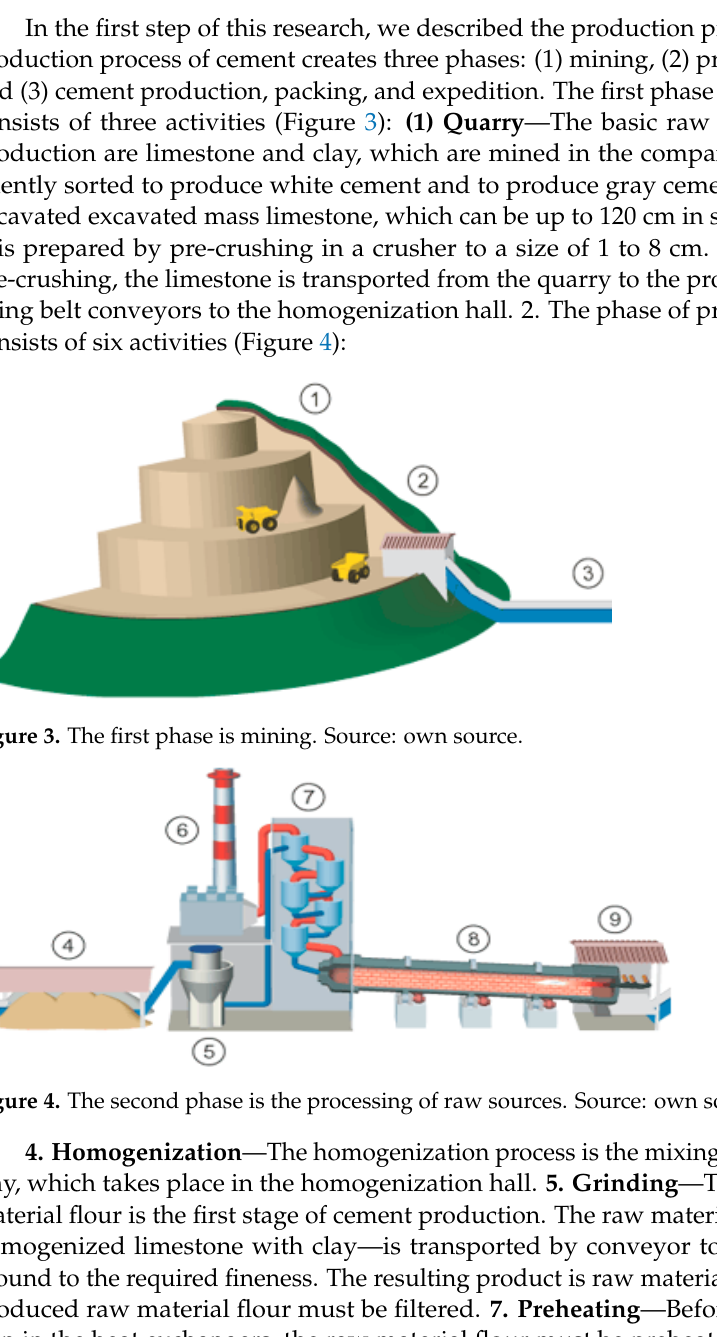
(Figure 5): 10. Completion of the process —The basic component of cement is